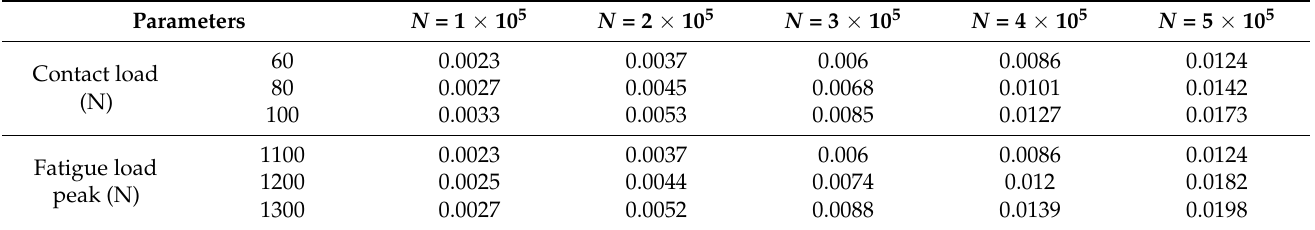
Table 2. Cross-sectional failure area of fatigue wire (pair: wire) under different contact and fatigue loads.